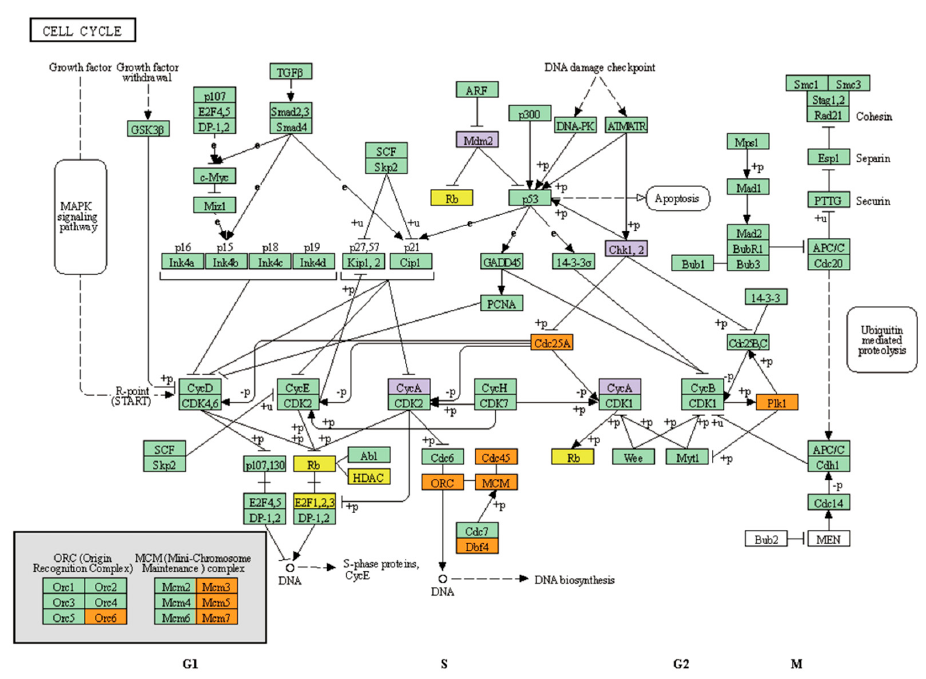
Figure 3. Over- and under-expressed genes are enriched in the human cell cycle pathway. The KEGG pathway map for the human cell cycle signaling pathway, has04110, was visualized using the KEGG mapper. Among the pathways, p53 and ATR/ATM shared a significant correlation with the identified genes. Genes associated with the p53 signaling pathway are boxed in yellow, ATR/ATM in orange, and common denominators for both pathways in purple.